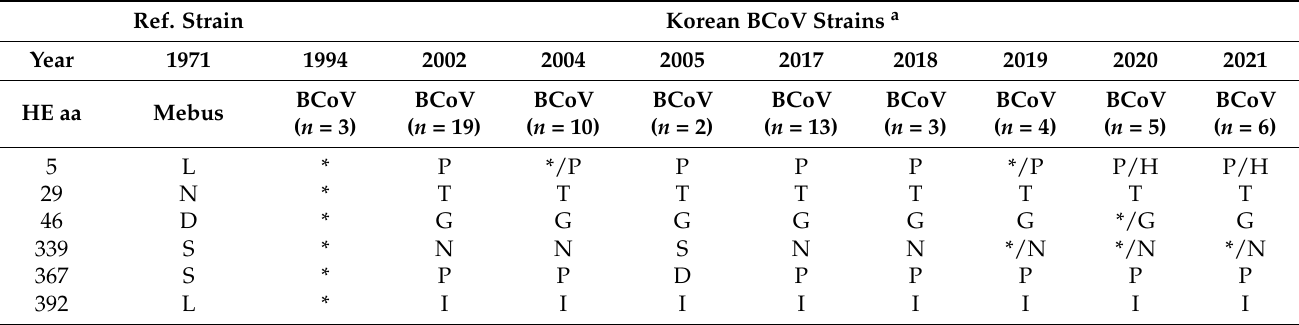
Table 3. Comparison of the deduced amino acid sequences for the HE genes of Korean